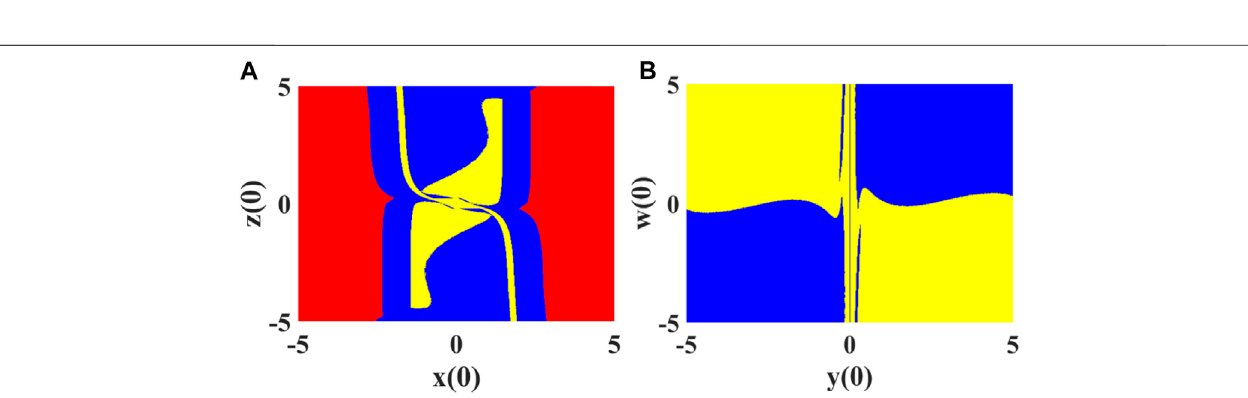
Frontiers in Physics |